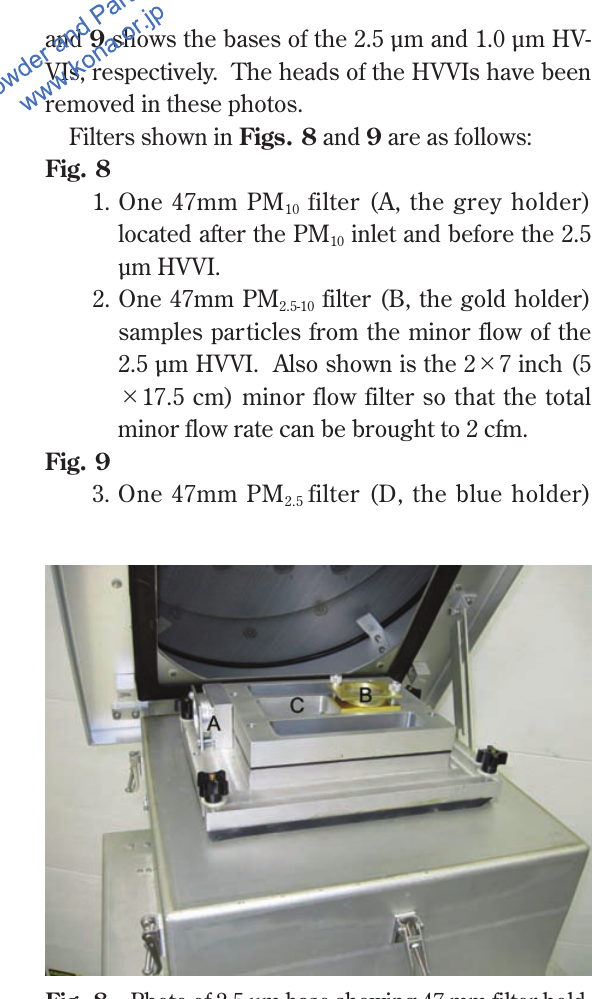
Fig. 8 Photo of 2.5 µm base showing 47 mm filter hold- er placements.